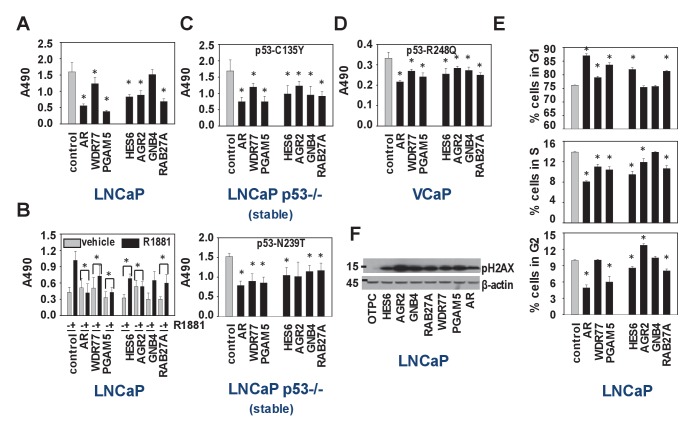
Biological consequences of WDR77-dependent AR and p53 interaction.(A) Silencing of regulators and effectors of the AR-WDR77-p53 transcriptional code decreases CaP cell viability. LNCaP cells were transfected with siRNAs targeting AR, WDR77, PGAM5, HES6, AGR2, GNB4 or RAB27A, or control siRNAs. Medium was changed 16 hr later, and an MTS assay reading absorbance at 490 nm was performed 96 hr after transfection. Columns, Mean values from five individual measurements; bars, SEM. (B) Viability experiment as under (A) except that cells were treated for 96 hr with vehicle (grey bars) or 5nM R1881 (black bars) at medium change after 16 hr. (C) Viability experiment described under (A) in p53-null LNCaP cells that stably express p53 C135Y (top panel) or N239T (bottom panel). (D) Viability experiment described under (A) in VCaP cells that endogenously express p53 R248Q. (E) Silencing of regulators and effectors of the AR-WDR77-p53 transcriptional code delays cell cycle progression. LNCaP cells were transfected and harvested as above. Cells were stained using propidium iodide and flow cytometry was performed. Columns, Mean values from three individual biological replicates; bars, SEM. (F) Silencing of regulators and effectors of the AR-WDR77-p53 transcriptional code alters phospho-H2AX expression. LNCaP cells were transfected as above. Cells were harvested and total protein extracts were subjected to western blot analysis using an antibody directed against phospho-H2AX. To control for potential loading differences, blots were stripped and reprobed with an antibody targeted at β-actin. Figure 6—source data 1 provides p-values for the data shown in panels A, B, C, D and E. *, significance with p<0.05 compared to control siRNA condition; stable, LNCaP cells in which endogenous expression of p53 had been silenced were stably transfected with expression vectors for p53 C135Y or p53 N239T.10.7554/eLife.28482.018Figure 6—source data 1.Summary of p-values for data presented in Figure 6.For panels A, C, D, and E, p-values were derived using welch two sample t-test. Values are compared to those obtained from the control siRNA group with changes considered significant at p<0.05. For panel B, p-values are derived using paired t-test. The fold change in values obtained after R1881 treatment is calculated for each siRNA group and values for specific siRNA groups are compared to those derived from the control siRNA group. Changes are considered significant at p<0.05.